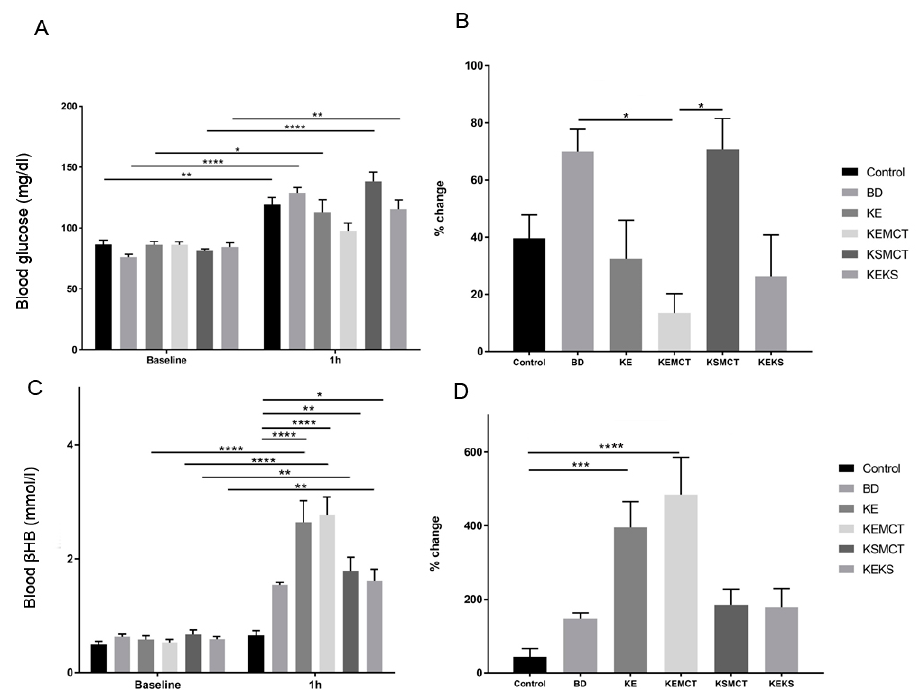
Figure 2. Changes in blood glucose and R - β HB levels of 1-year-old SPD rats after 1 h of treatment, in post-exercise state. ( A ) In KEMCT group the blood glucose level was not significantly elevated, compared to baseline. ( B ) The corresponding percent change in glucose levels. ( C ) The resulting blood R - β HB levels. ( D ) The percent change in the blood R - β HB levels. Abbreviations: SPD: Sprague-